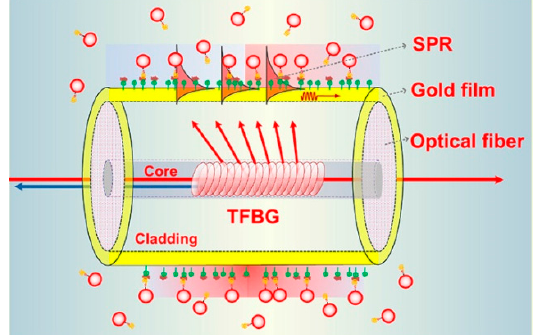
Figure 6. Configuration of Au NPs LSPR fiber sensor based on TFBG [106].